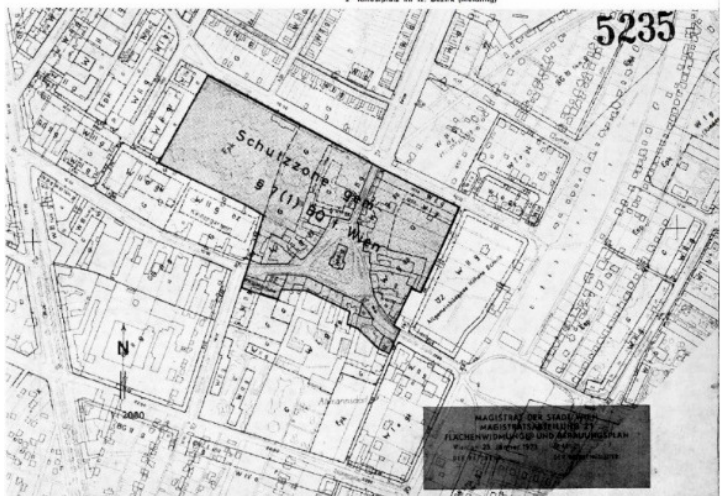
Figure 8. Schutzzone Khleslplatz (1120 Wien): Core settlement Altmannsdorf, Schutzzone since 1973. Source: Koller (1973, p.